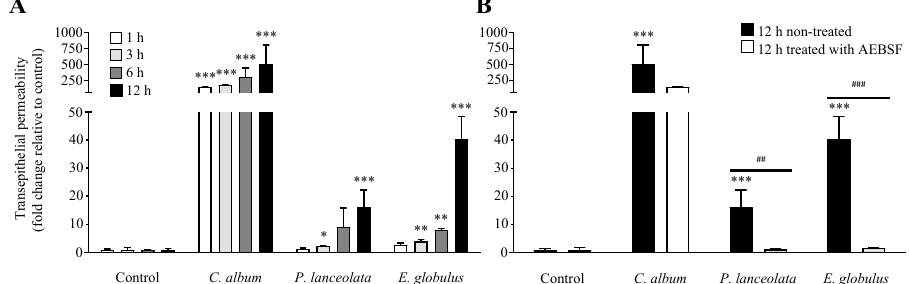
Figure 2. E ff ect of pollen proteases from Chenopodium album (0.26 ± 0.06 mg / mL), Plantago lanceolata (0.18 ± 0.03 mg / mL) and Eucalyptus globulus (0.75 ± 0.18 mg / mL) on the paracellular permeability of epithelial cells. ( A ) Time-course e ff ect of pollen di ff usates on Calu-3 cells. ( B ) E ff ect of untreated pollen di ff usates (black bars) and di ff usates treated with 1 mM AEBSF (white bars) on the transepithelial permeability of Calu-3 cells. Cells incubated with culture medium were used as a control for this assay. Bonferroni post-test: *** p < 0.001; ** p < 0.01; * p < 0.05 ( n = 3) in comparison to the control condition, and ### p < 0.001; ## p < 0.01 ( n = 3) for comparisons between treated and untreated conditions.